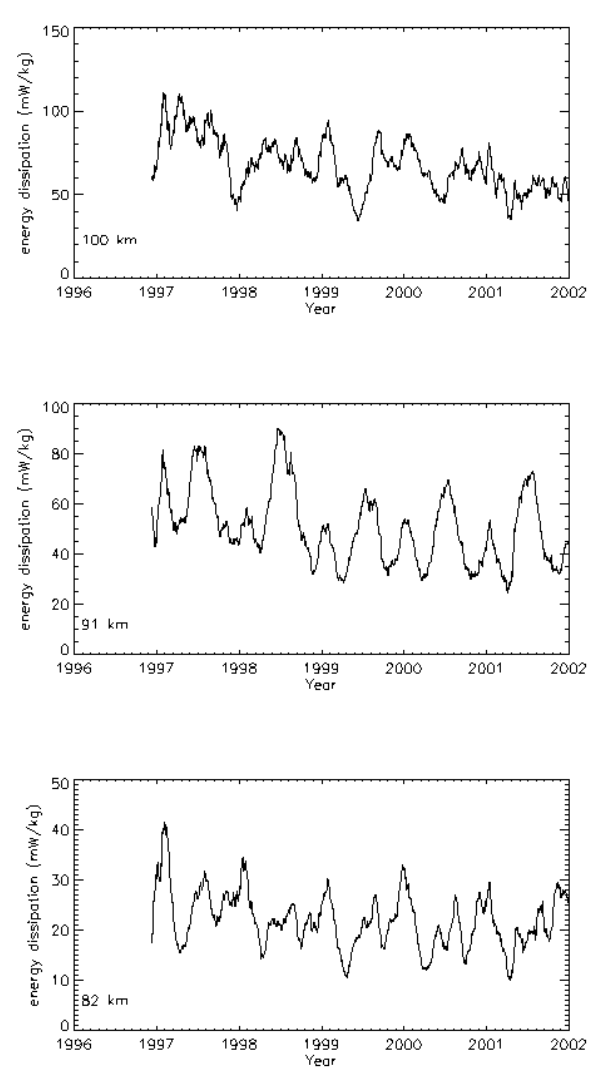
Fig. 2. Time series of ε 0 for the three selected heights 82, 91 and